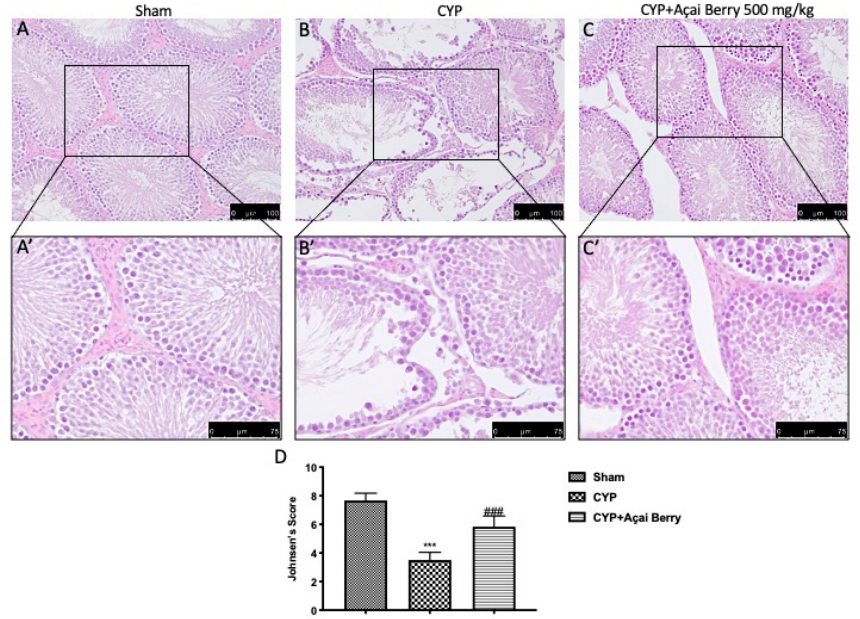
Figure 6. Effect of açai berry administration on testis architecture. Histological photographs of testicular tissue and relative higher magnification in ( A,A’ ) sham, ( B, B’ ) CYP, and ( C,C’ ) açai berry treatments. ( D ) Graphical representation of Johnsen’s score. *** p < 0.001 vs. sham; ### p < 0.001 vs. CYP.